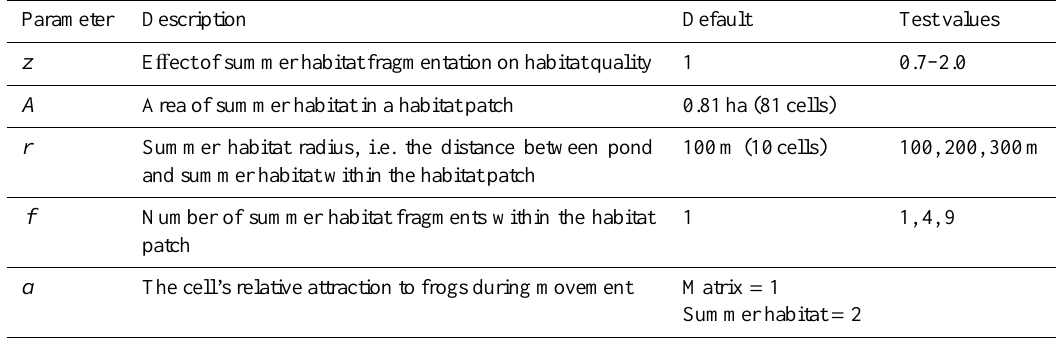
Table 1. Default settings of parameters and the range of parameter values used in the simulations and calculations.